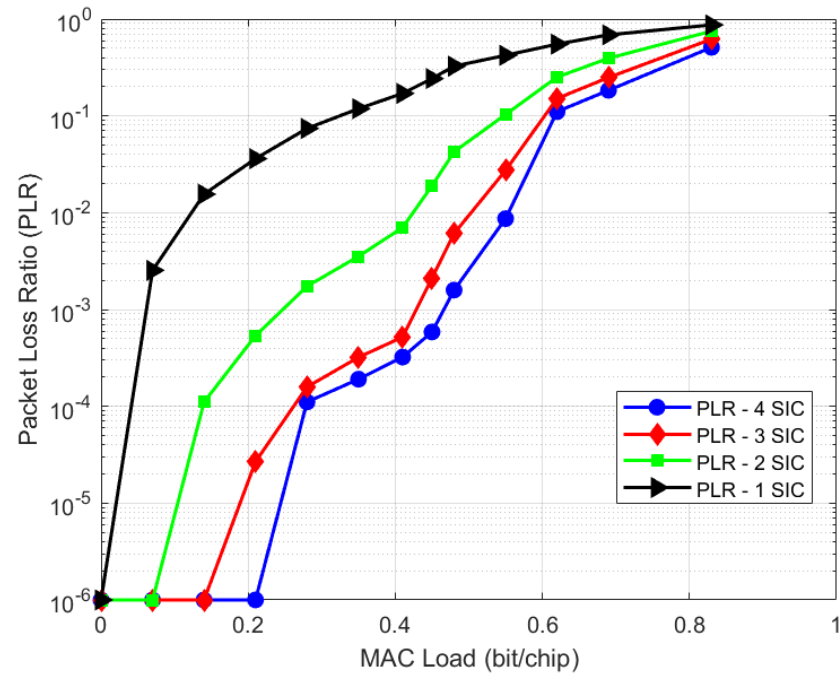
Figure 22. UC#3 IURA throughput performance per SIC iterations.